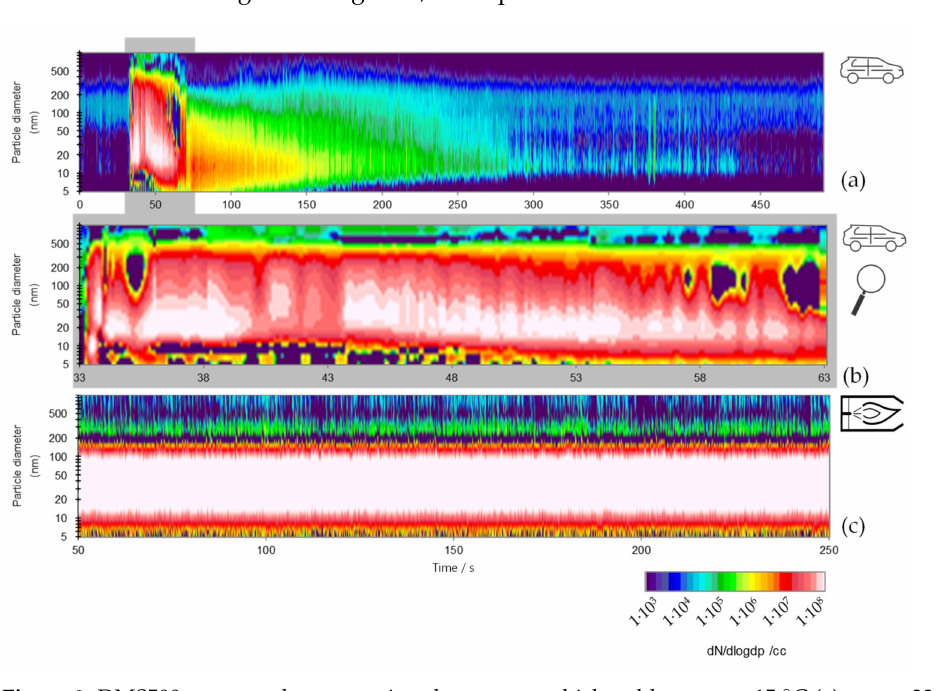
Figure 9. DMS500 contour plot comparison between a vehicle cold start at − 15 ◦ C ( a ), zoom 33–63 s ( b ), and the burner test bench ( c ) operated with the parameter set presented in Table